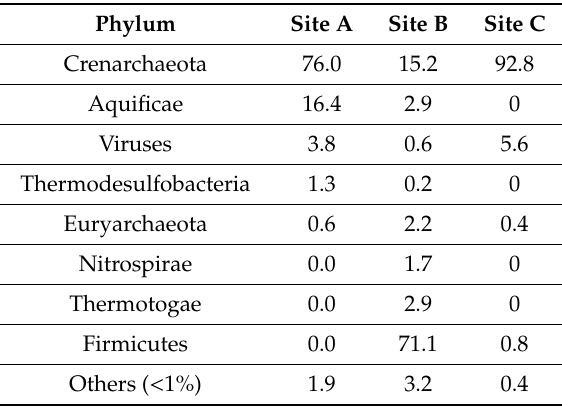
Table 6. Taxonomic assignment of